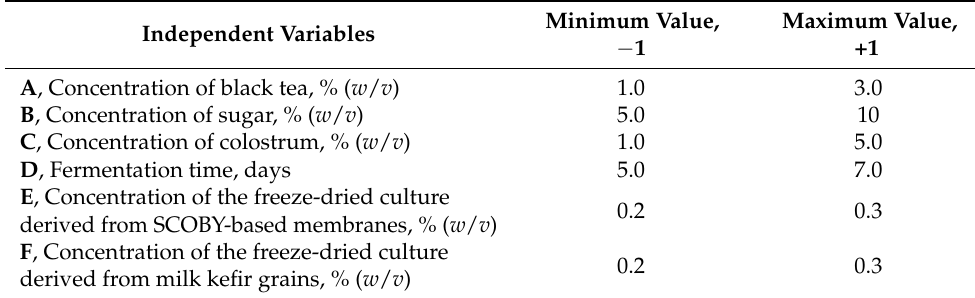
Table 1. Independent variables and their levels of variation established through the PB design. Independent Variables